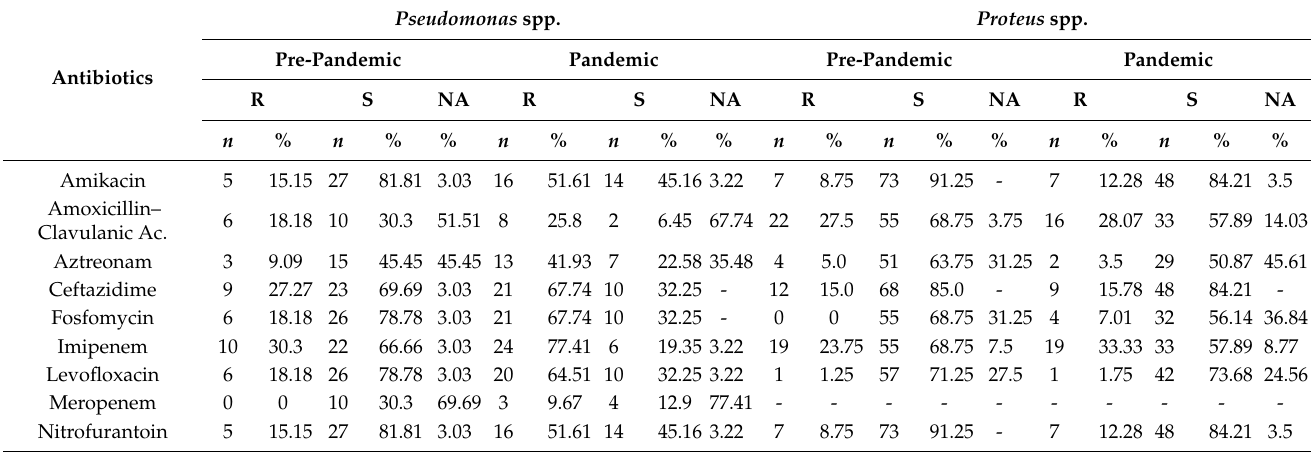
Table 4. Antibiotic resistance profile in Pseudomonas spp. and Proteus spp.